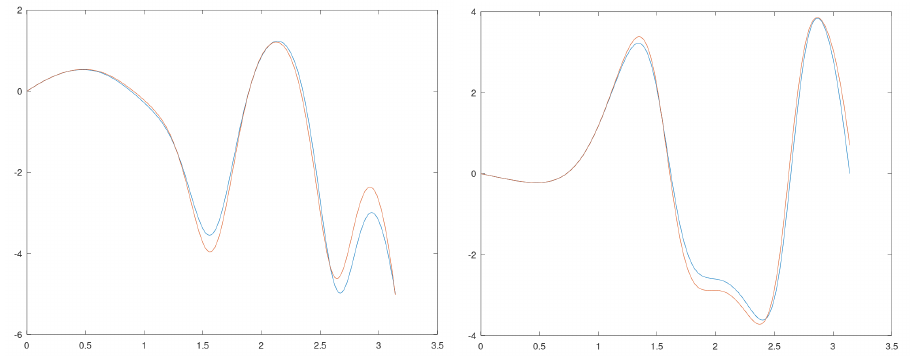
Figure 2. Plots of Re q 0 ( x ) , Re ˜ q 0 ( x ) and Im q 0 ( x ) , Im ˜ q 0 ( x ) for δ =